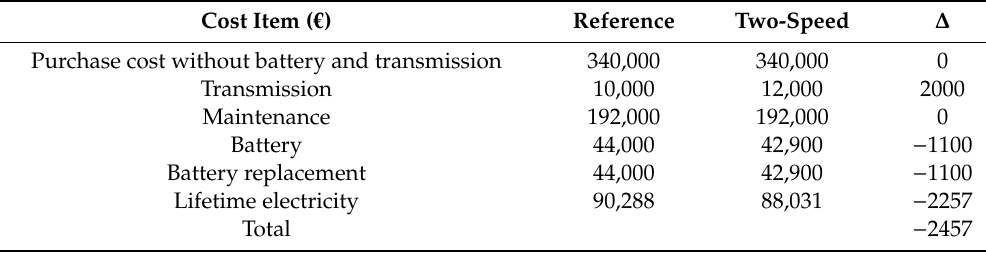
Table 6. Comparison of lifecycle costs between the reference and two-speed gearbox vehicles for the Braunschweig cycle. Energy consumption advantage of the two-speed gearbox is translated proportionally to battery capacity and